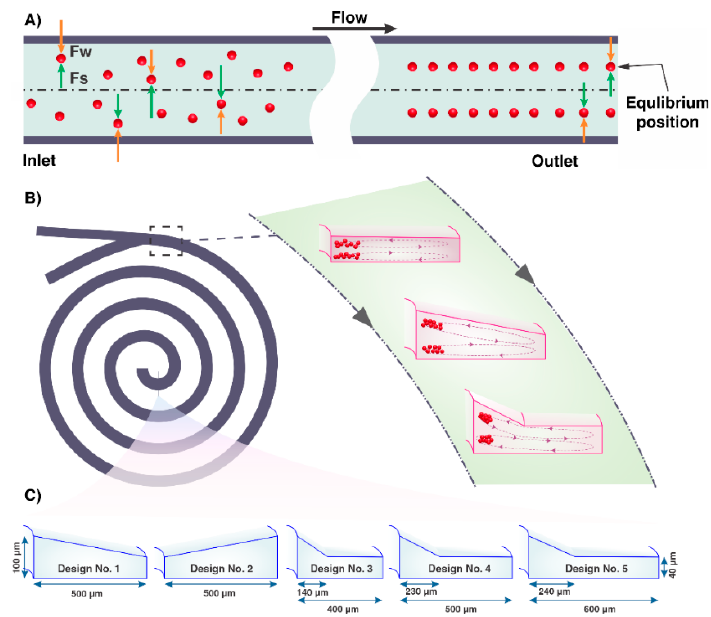
Figure 1. ( A ) The schematic illustration of particle focusing in straight rectangular microchannels. Particles that are initially dispersed will gradually migrate to their equilibrium positions and remain well-focused and stable due to the balance of opposing forces related to the shear gradient lift ( F S ) and wall interaction lift ( F W ) forces. ( B ) Schematic of spiral microchannels. Dean flow generates two counter-rotating vortices perpendicular to the main flow direction. ( C ) Schematic of a cross-sectional view of the channels used in this work.